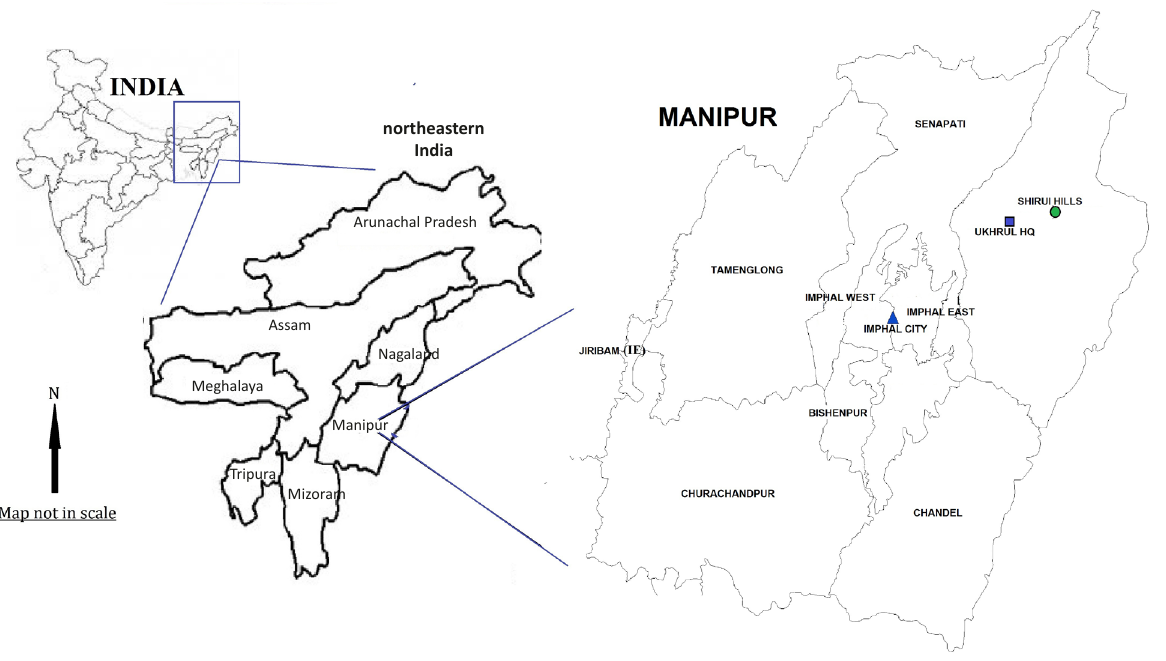
Figure 1. Study area; Shirui Kashong Peak and surrounding Shirui Village, Ukhrul District, Manipur, India (Map prepared by using DIVA GIS